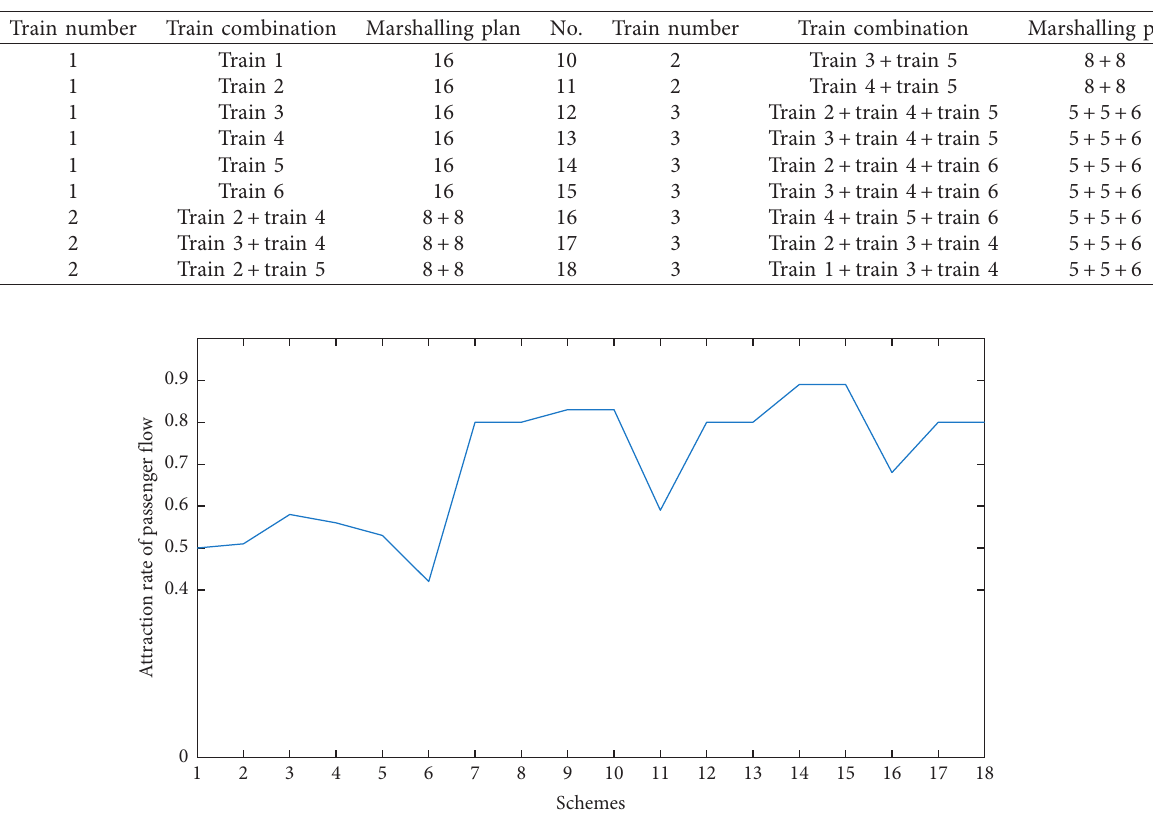
Figure 5: Attraction rate of passenger